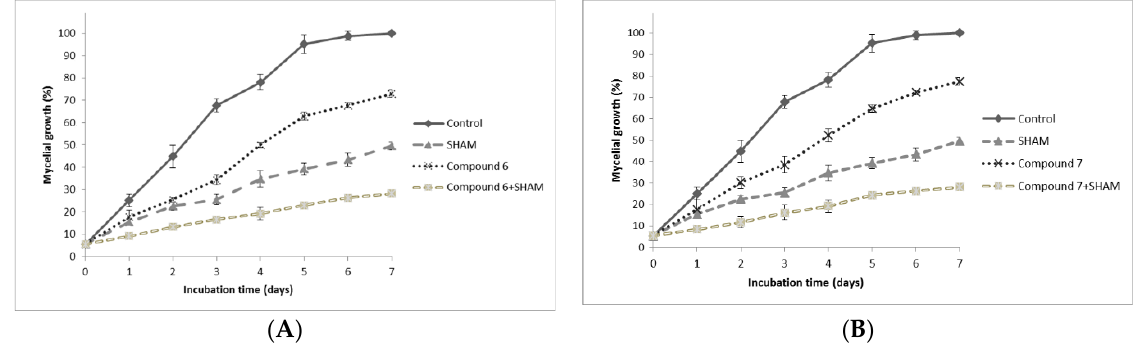
Figure 4. Effect of compound 6 ( A ) and compound 7 ( B ) at a concentration of 0.26 and 0.20 mM, respectively, on B. cinerea mycelial growth in the presence or absence of SHAM. Data shown correspond to three independent essays. Each essay was done in triplicate, and bars correspond to standard